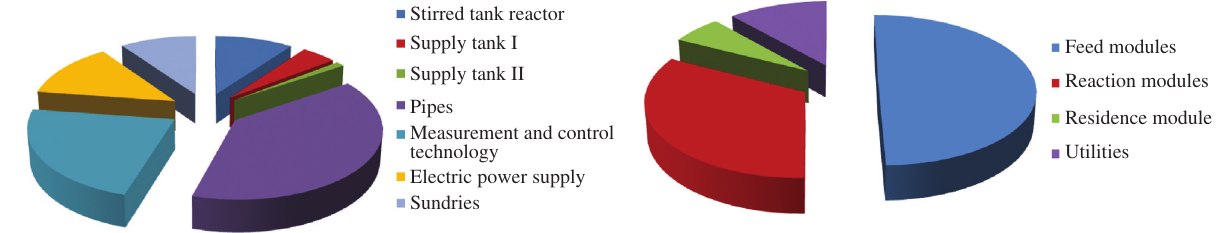
Figure 6 Composition of theoretical investment costs for an epoxi- dized soybean oil (ESBO) fed-batch production plant.